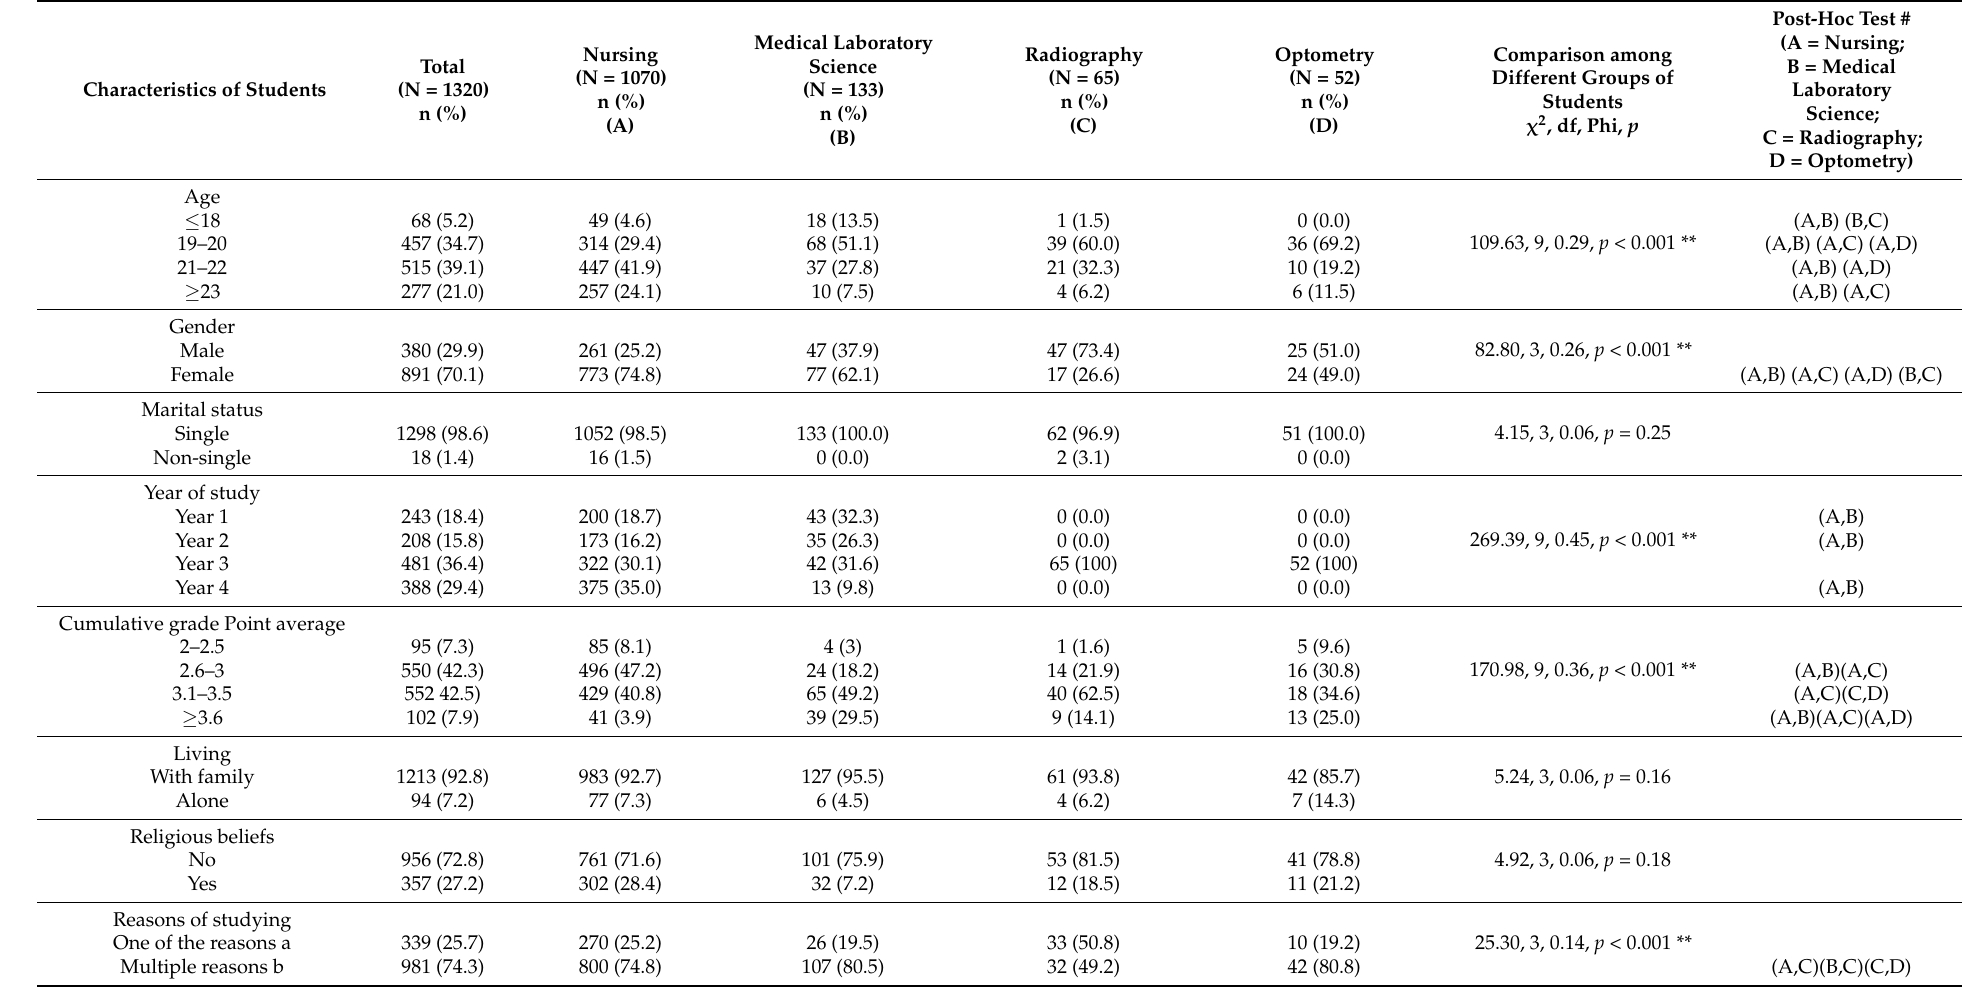
Table 1. Characteristics of the health-care